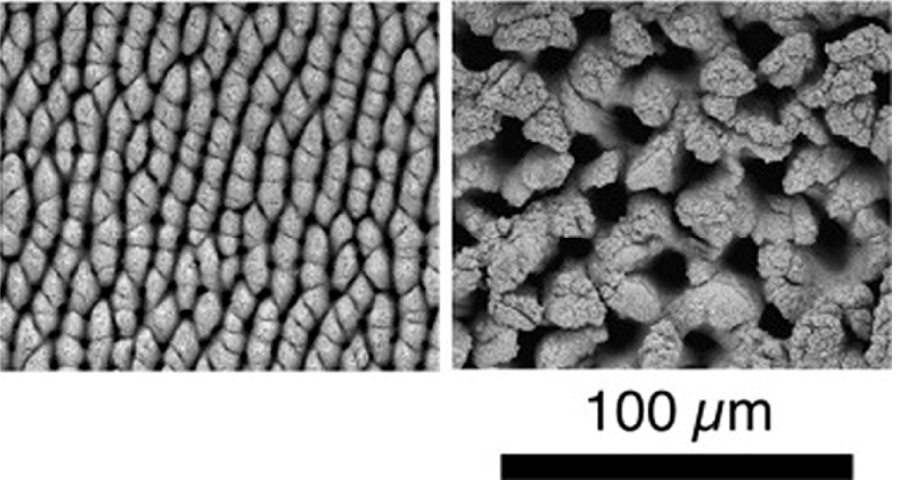
Figure 9. Columnar and chaotic structures on 304 stainless steel. “Reprinted with permission from